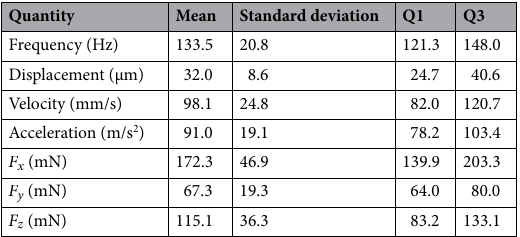
Table 1. Thorax kinematics (frequency and displacement/velocity/acceleration amplitudes) averaged across the population (n = 10).